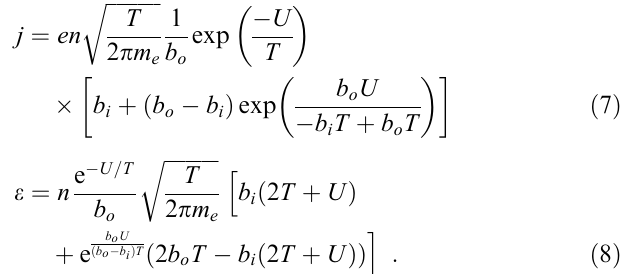
Fig. 3. SM: single-Maxwellian source plasma without potential structures or non-adiabatic processes. The gray dots show downgoing electron flux at the upper boundary, the black dots (which are mostly overlapped by the gray dots in this case) are the upgoing electrons at the upper boundary, and the triangles show the particle flux entering in the ionosphere at s (cid:136) 1 : 01725. For low energies, some inaccuracy due to numerical noise can be